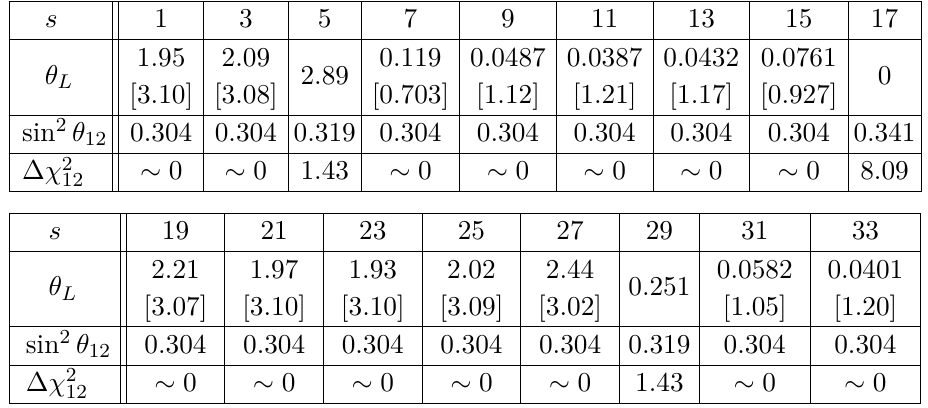
Table 8 . Case 3 a) Results for n = 34 , m = 2 and s odd. The lepton mixing angles θ 13 and θ 23 are fixed to sin 2 θ 0 . 0225 and sin 2 θ 0 . 607 . We display θ , sin 2 θ and ∆ χ 2 for light neutrino 13 ≈ 23 ≈ L 12 12 masses with NO. We write ∼ 0 when ∆ χ 2 < 10 − 3 . The presence of a second best fit value for θ L is 12 indicated in square